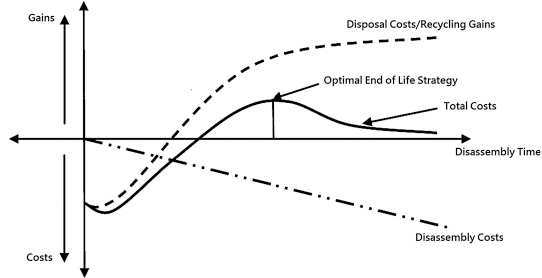
Figure 1. Cost–benefit curve–disassembly depth.